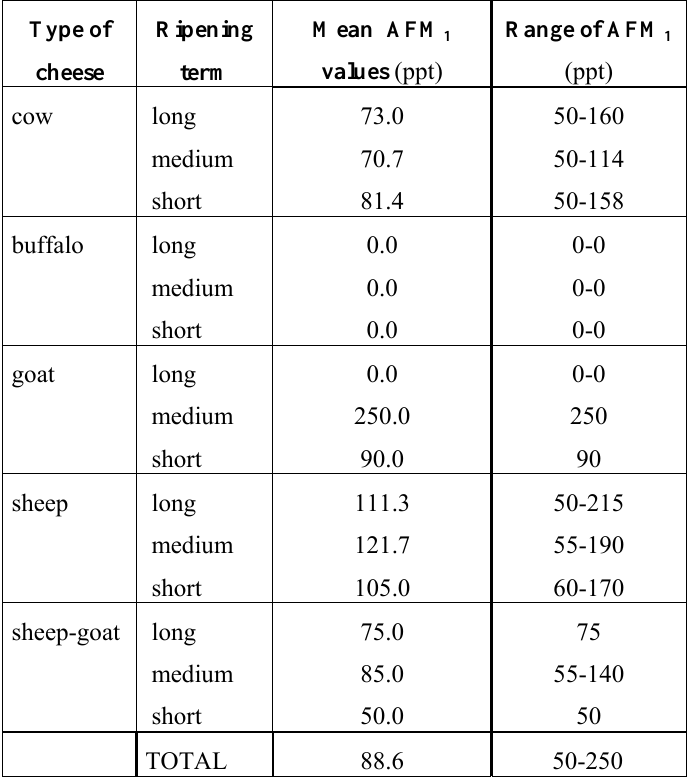
in positive cheese samples of different type and 1